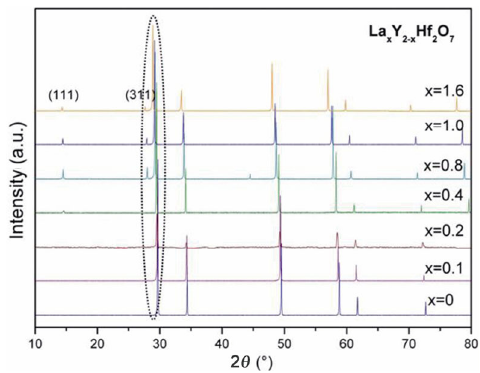
Fig. 10 XRD patterns of La 2– x Y x Hf 2 O 7 ceramics ( x = 0– 1.6) sintered at 1900 ℃ for 6 h. Reproduced with permission from Ref. [90], © Chinese Academy of Sciences